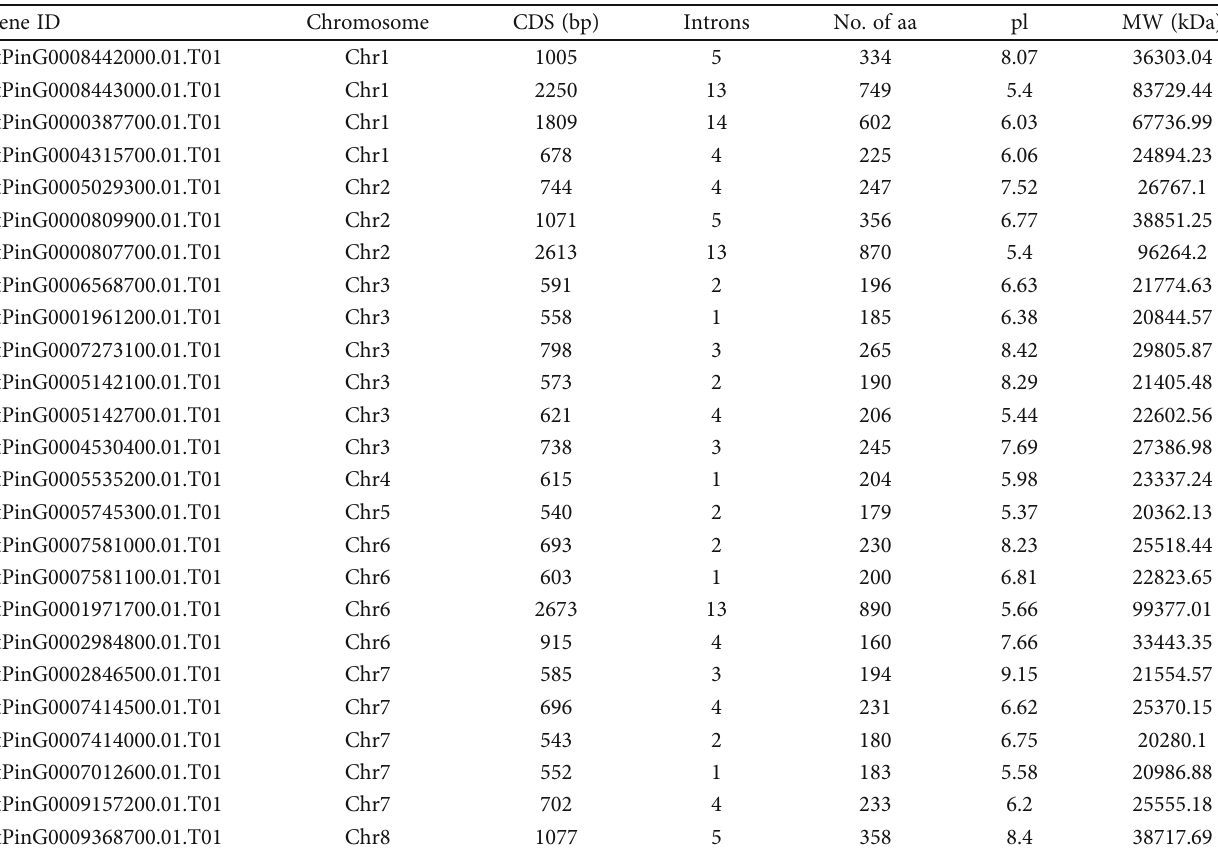
Table 1: Aux/IAA family in